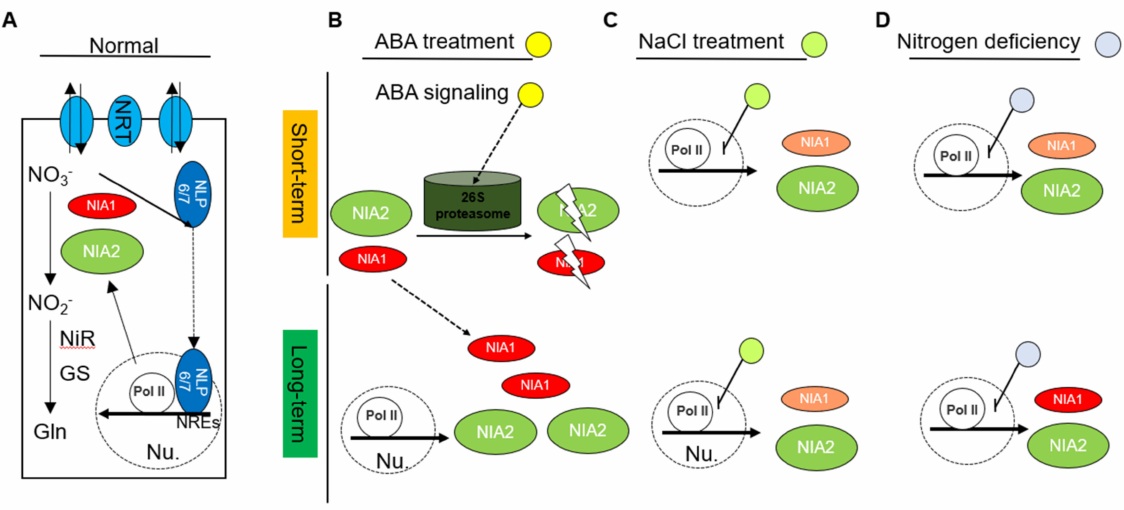
Figure 6. Schematic diagrams display the regulation of nitrate reductases in response to abiotic stress. ( A ) Under normal conditions, the expression levels of NIA1 and NIA2 are highly controlled in a transcriptional manner. Nitrate supplementation triggers the trans-localization and retention of NLP6/7 in the nuclear, in which they can bind to the NREs to promote the expression of NIA1 and NIA2 ; ( B ) under short-term ABA treatment, the NIA1 protein and NIA2 protein are degraded via a 26S proteasome-dependent manner. Under long-term ABA treatment, the expression level of NIA2 is upregulated, contributing to the accumulated NIA2 protein. Meanwhile, the long-term ABA treatment might gradually reduce the protein degradation of the NIA1 protein to promote its accumulation for better adaptation; ( C ) under short-term NaCl treatment, the expression level of NIA1 is decreased, contributing to the disappearance of the NIA1 protein. The NIA1 protein will also gradually decrease with the extension of the treatment time, and NIA2 has no obvious change. Under long-term salt stress, the decrease in the transcription of NIA1 and the disappearance of NIA1 proteins also cannot be recovered. In contrast, both the expression level and protein level of NIA2 are only partially reduced under short-term or long-term NaCl treatment; ( D ) under nitrogen deficiency conditions, both the expression and protein levels of NIA1 and NIA2 are strongly inhibited. Along with prolonging the nitrogen deficiency conditions, the expression and protein levels of NIA1 and NIA2 gradually recovered to the pre-treated